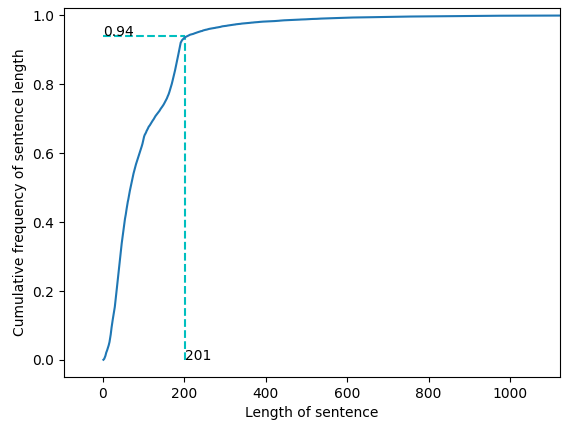
Figure 6. Graph of the cumulative distribution function of sentence length.